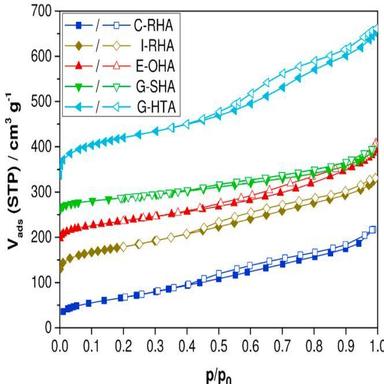
Nitrogen sorption isotherms of the biogenic silica samples (shifted for visual clarity by an offset of 50 cm3 g− 1 relative to the preceding isotherm); C-/ I-RHA: rice husk ash (Cambodia/Italy), E-OHA: oat husk ash (Europe), G-SHA: spelt husk ash (Germany), G-HTA: horsetail ash (Germany).